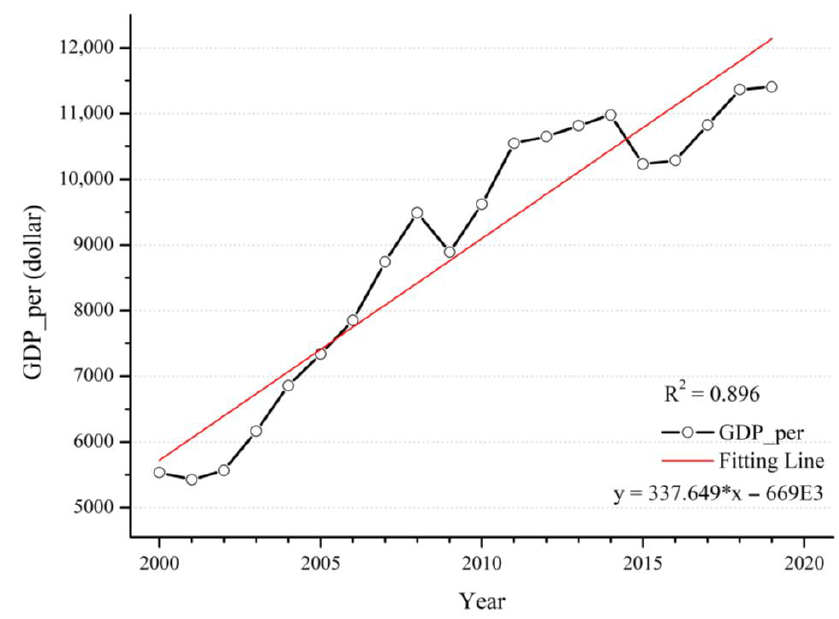
Figure 9. Time series of GDP per capita from 2000 to 2019. NTL can be a good measure of the socioeconomic development of a region. Most developed countries, such as the United States, South Korea, and the European Union region, have shown an extremely significant increasing trend of NTL during the past 20 years, but the trend of PM 2 . 5 concentration in these regions has not increased with the increase in human activity intensity. Instead, these areas show a decreasing trend, which is most likely because developed countries have invested more money in environmental management and protection and have achieved certain management results. In addition, different countries and regions have different development routes and priorities, resulting in economic development while failing to consider environmental pollution control. For this reason there is an increasing trend of PM 2 . 5 concentration, mainly occurring in India, the Middle East, Chile, Colombia, and other developing regions. Moreover, in Canada, Japan and other regions, NTL shows a decreasing trend, and the PM 2 . 5 concentration in these regions also shows the same trend; perhaps the reduction in the intensity of human activity has also effectively controlled the reduction in anthropogenic emissions (Figure 10).